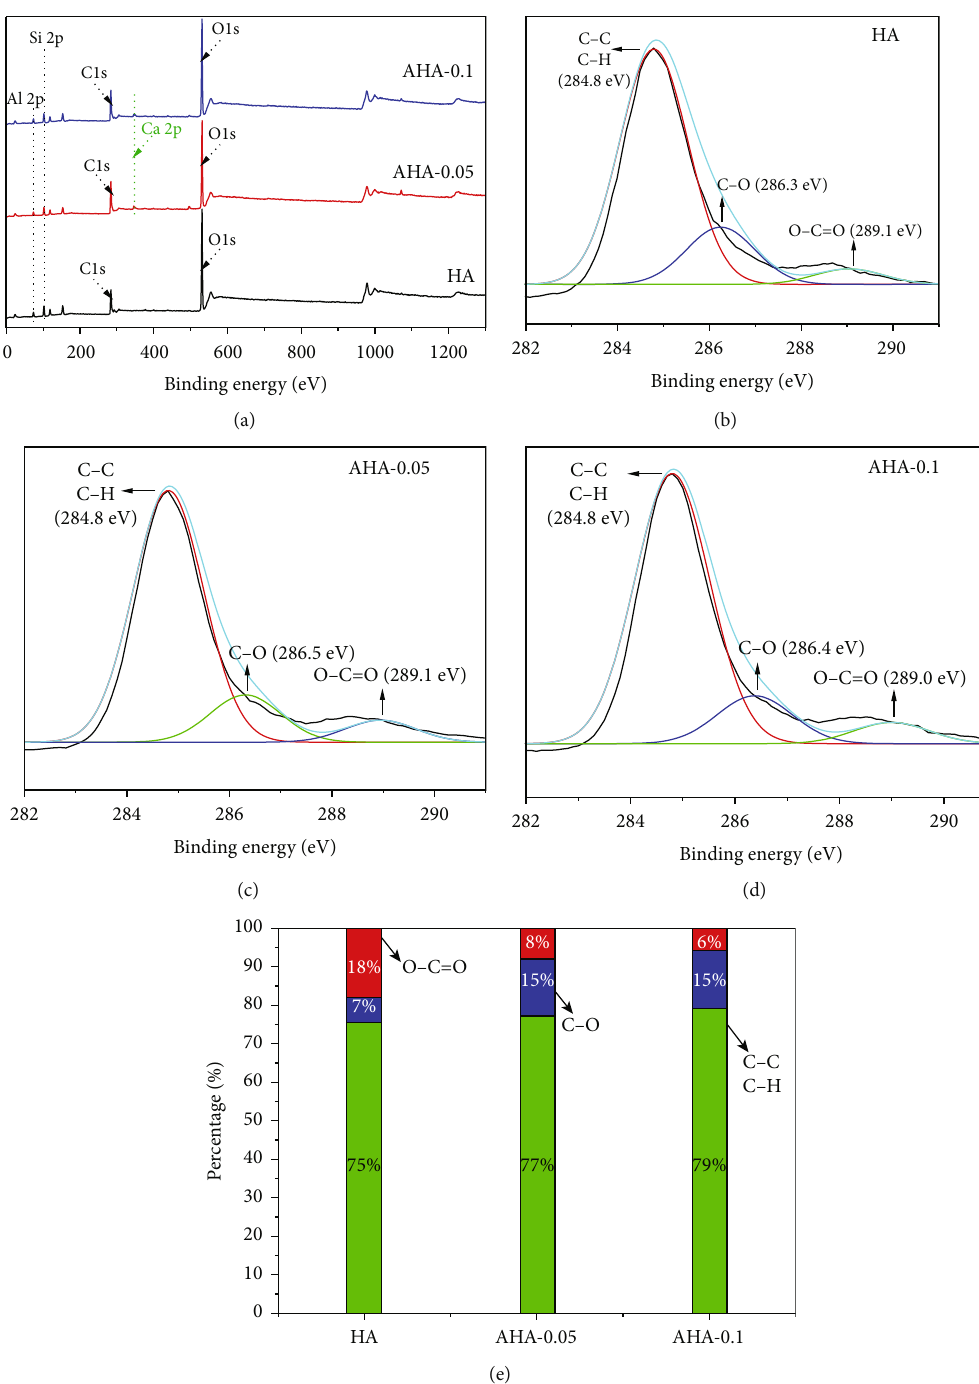
Figure 6: (a) XPS full scan spectra of HA and AHA samples; high resolution C1s XPS spectra of (b) HA (c) AHA-0.05, and (d) AHA-0.1; (e) the percentage of di ff erent functional groups carried by HA, AHA-0.05 and